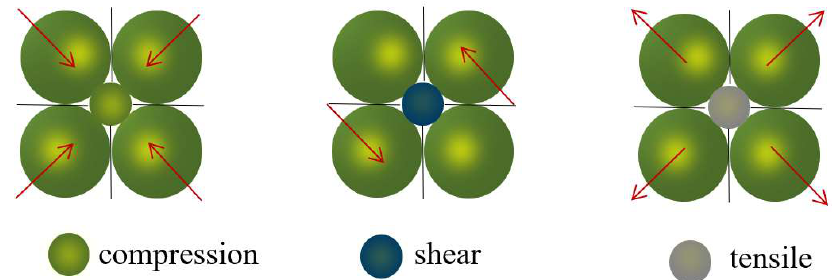
Figure 5. Generation process of an AE event: ( a ) is the start of an event and ( b ) is the finish state of this event.